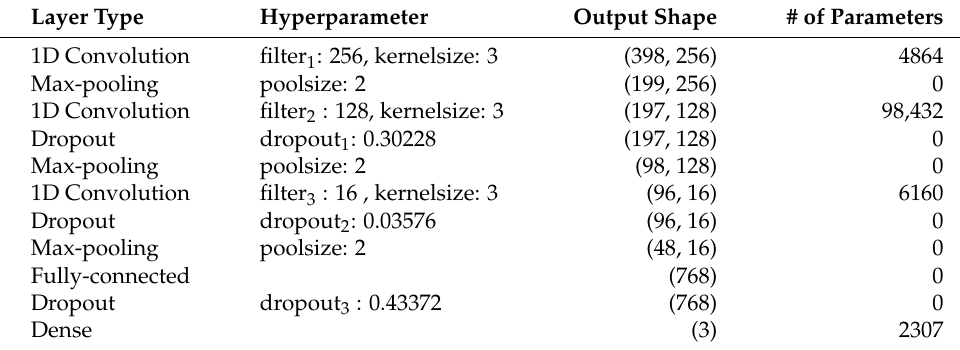
Table 2. Overview of all layers and model parameters of the proposed CNN architecture. The output shape is given for one